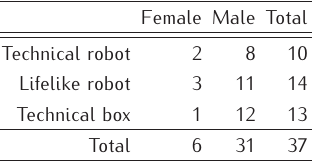
Table 3. Distribution of participants across the experimental